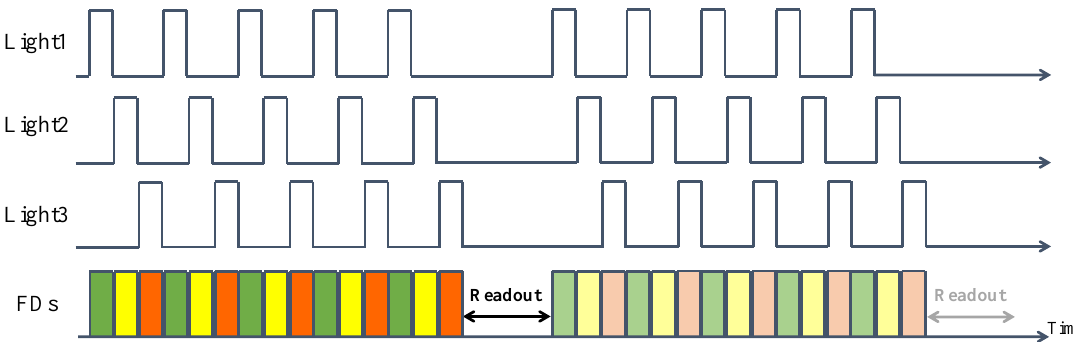
Figure 5. Timing chart for synchronization between the light sources and the exposure times of the different FDs. Each color at the bottom of the figure represents a different FD as shown in Figure 4. The light sources are fully synchronized with the gate signals of each of the FDs. After readout, image1 from FD1 contains only light emitted by light1. Image2 and image3 also only contain light emitted by light2 and light3,